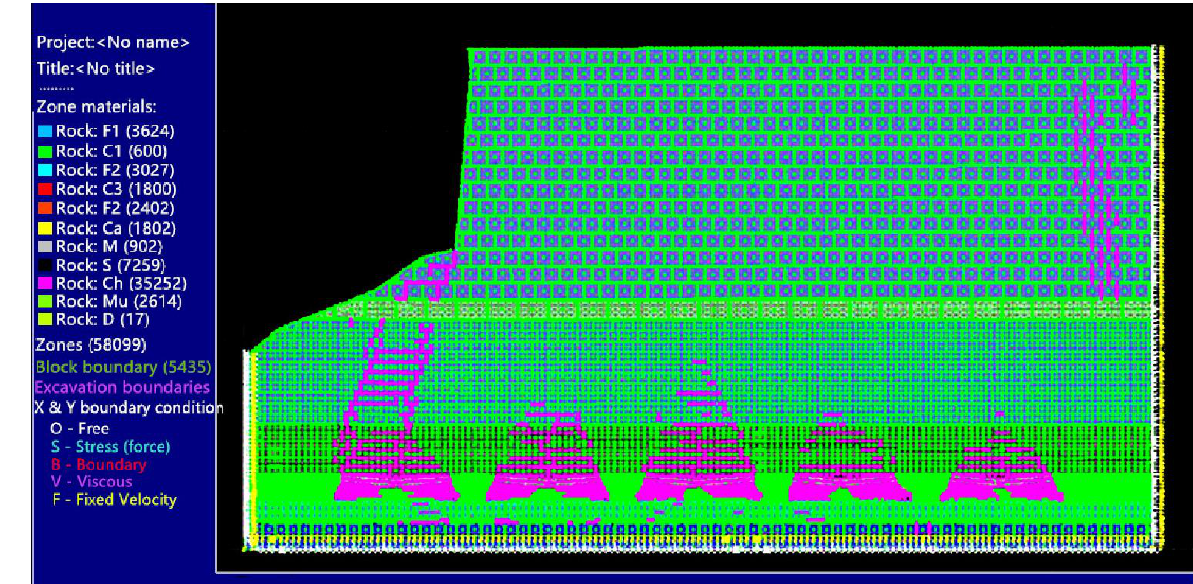
Figure 7. Diagram showing the effect of leaving a partial coal pillar.